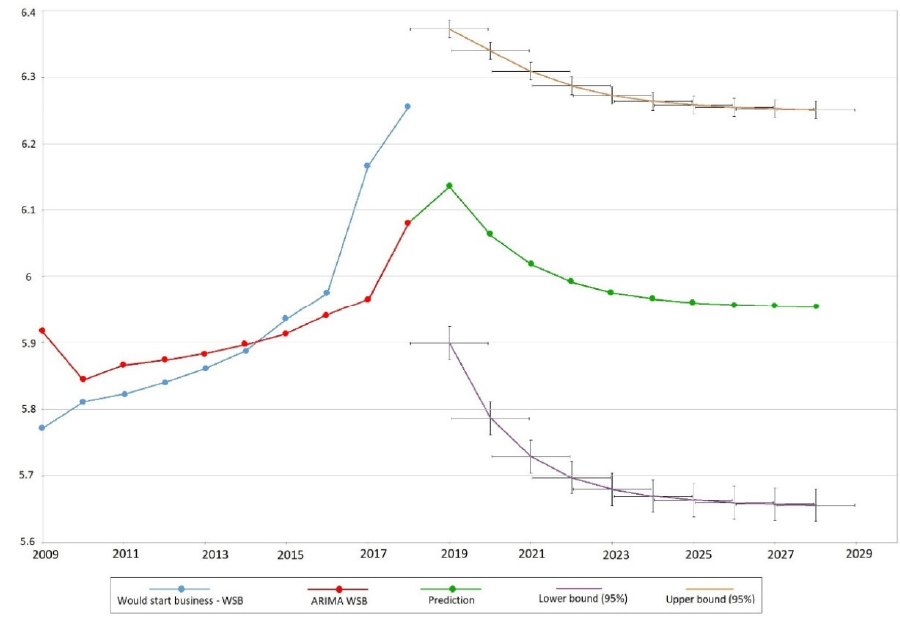
Figure 2. ARIMA forecasting graph (without non-significant predictors).